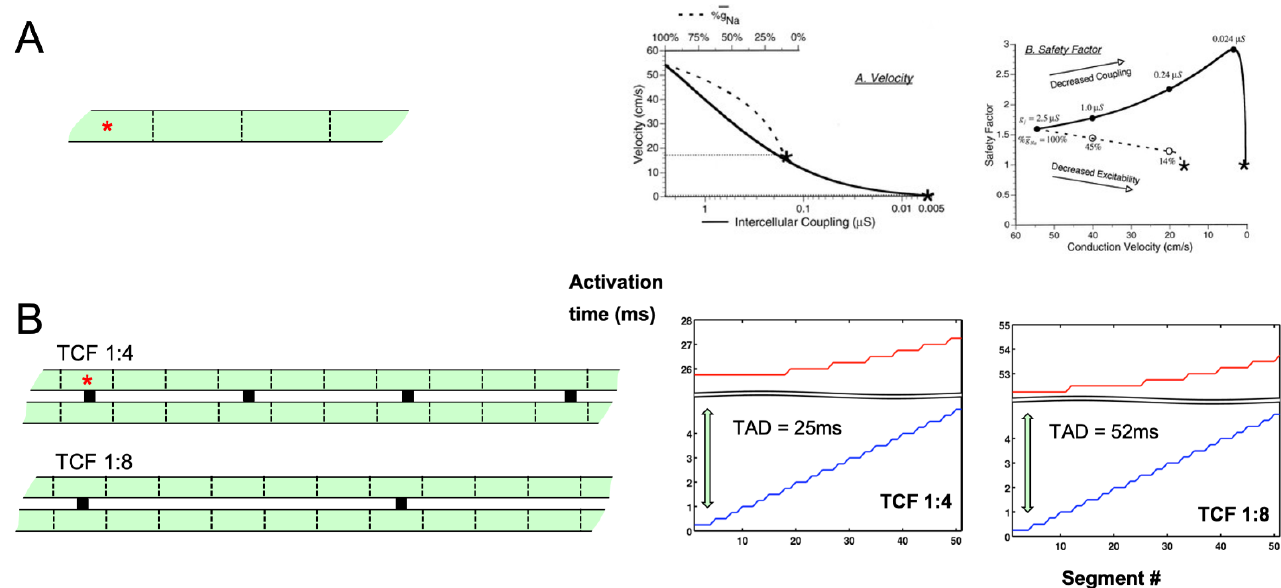
Figure 4. Characteristics of longitudinal and transverse propagation. ( A ) Linear strand of longitudinally coupled myocytes (left panel). When the sodium current was reduced, propagation velocity decreased by about 60% when conduction block appeared (middle panel, dashed line). Until that point, the safety factor for conduction decreased monotonically. When gap junctional coupling was reduced, the conduction velocity could be reduced to much lower values before the block occurred (middle panel, solid line). Under these conditions, the safety factor initially increased, and the action potential upstroke became increasingly dependent on the calcium current, adapted from [14]. ( B ) Two strands of longitudinally coupled myocytes connected by discrete transverse connections every fourth (1:4) of eight (1:8) elements. The paced upper strand activated rapidly (right panels, blue lines), while the non-paced lower strand activated within a very short period (right panels, red lines), but after a long transverse activation delay (TAD), which was highly sensitive to the number of transverse connections. Under these conditions, the action potential upstroke in the non-paced strand was still sodium-dependent, but the calcium current in the paced strand was required to maintain the plateau in the paced strand over the long duration of the TAD, adapted from [17]. Red asterisks indicate pacing sites.